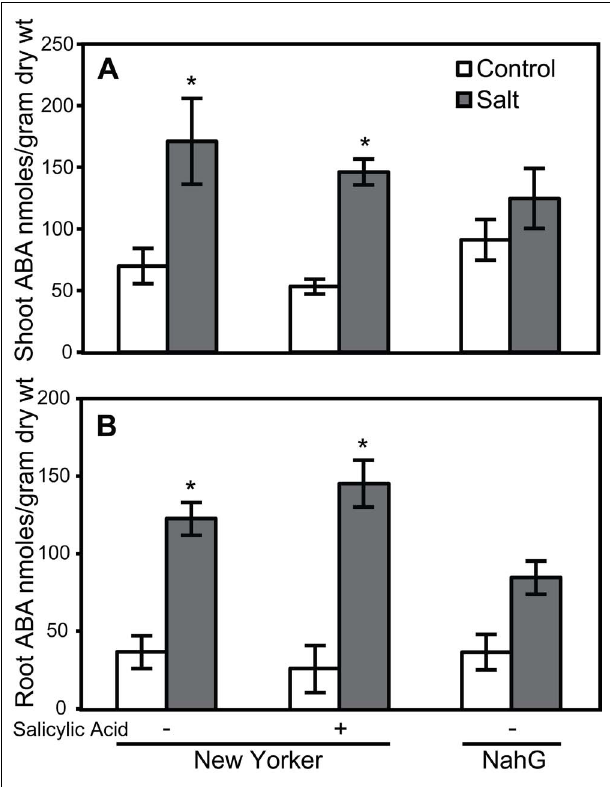
FIGURE 7 |ABA accumulation in shoots (A) and roots (B) of “New Yorker” plants non-stressed (control) or salt-stressed (0.2 M NaCl/0.02 M CaCl 2 ) for 18 h, with and without priorTDL or BTH treatment. Values are the means ± SE from three experiments ( n = 9). Asterisks indicate a significant increase in shoot (A) ( χ 2 = 8.65, P = 0.003) and root (B) ( χ 2 = 5.78, P = 0.016) ABA in “NewYorker” salt over “New Yorker” control byWilcoxon rank